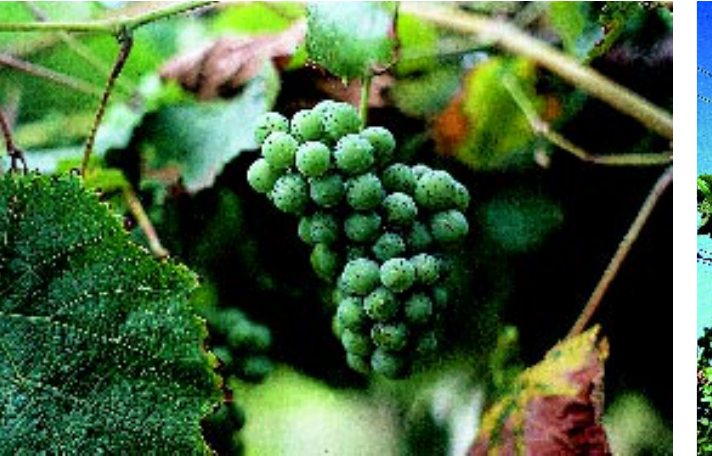
Fig. 3. An old grapevine with symptoms of esca showing dark spots on the berries and chlorotic foliage.